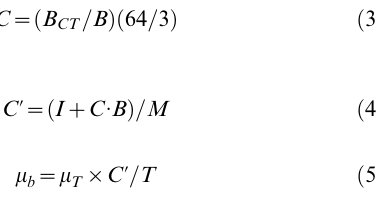
Figure S1 Plasmid shuffling strategy. Mutated pol3 alleles were introduced into MSH6 and msh6 D yeast by plasmid shuffling. Haploid yeast with a chromosomal deletion of POL3 ( pol3 D ) complemented by a wild-type POL3 – URA3 plasmid (left) are transformed with mutant pol3–LEU2 plasmids. Individual colonies carrying both the pol3 and POL3 plasmids are isolated (center), and dispersed cells are then plated on 5-fluoroorotic acid (FOA) media URA3 vector (right). Figure S2 Mutagenesis screen of the Pol d exonuclease domain. Each allele was engineered into a wild-type POL3 vector (YCplac111POL3) by site-directed mutagenesis and then intro- duced into yeast by plasmid shuffling (see Figure S1). Independent FOA-resistant colonies were patched onto synthetic complete (SC) plates and then replica-plated to SC plates lacking arginine and containing canavanine (60 m g/ml) to assess mutator phenotypes phenotypes. Each plate has twelve or thirteen patches of cells derived from independent colonies of the indicated genotypes.